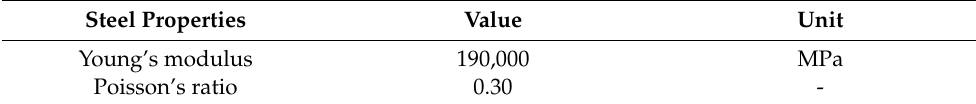
Table 3. Elastic constants of the material model of fasteners; see Johanides 2022 [44]. Steel Properties